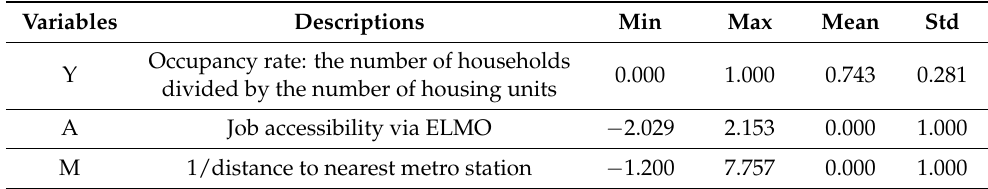
Table 1. Definition and description of main